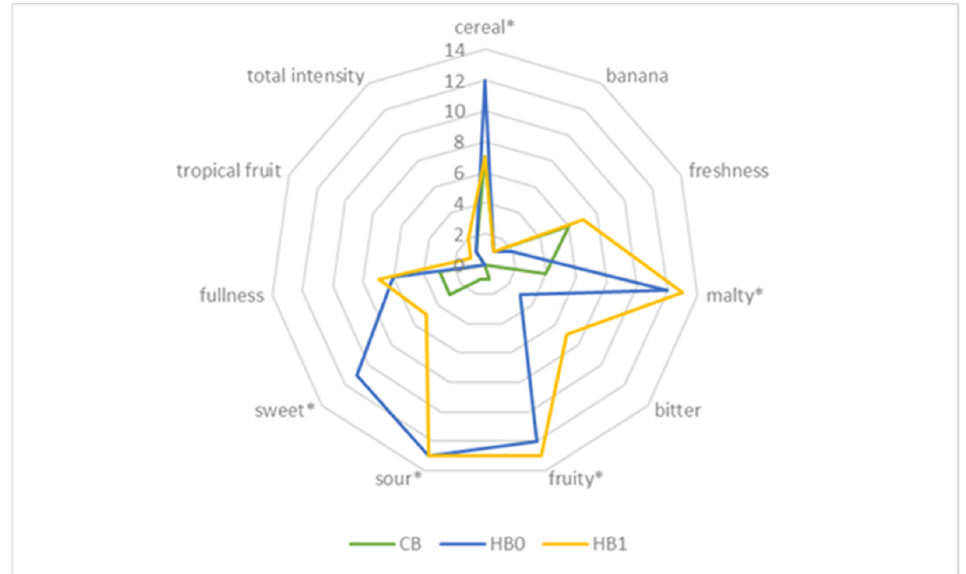
Figure 3. Sensory profile of wheat beers—control (CB) and sample with addition of the cv. ‘Honeywood’ fruit untreated (HB1) and treated with ozone (HB0) (* marks the attributes which were statistically different at p ≤ 0.05).